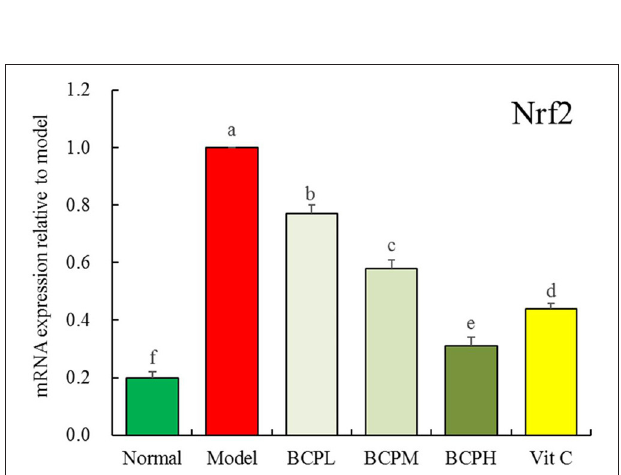
FIGURE 7 | Effect of BCP on mRNA expressions of Bcl-2, Bax, Casepase-3, Nrf2, HO-1, and NQO1 of H9c2 cells with OS injury. a − f Mean values with different letters over the bar are significantly different ( P < 0.05) according to Tukey’s honestly significant difference.